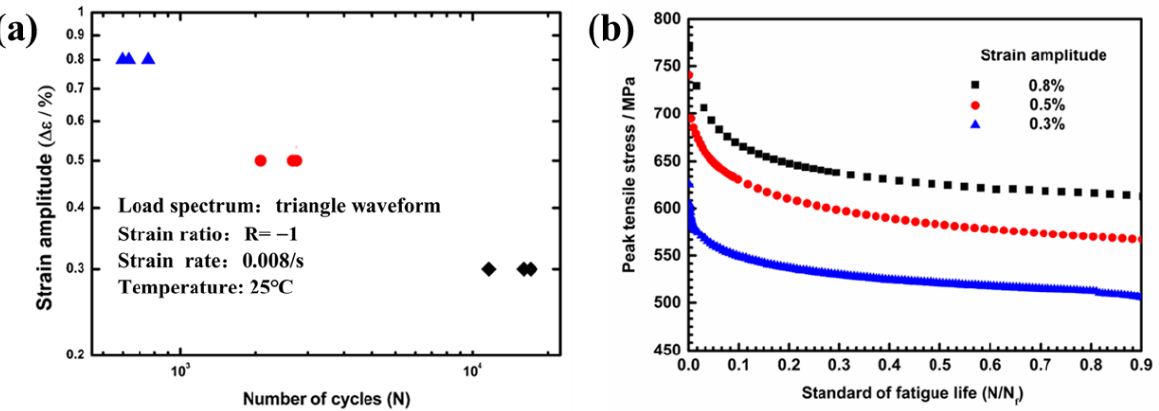
Figure 3. The relationship of strain amplitude with fatigue life ( a ) and peak tensile stress with normalized fatigue life ( b ).